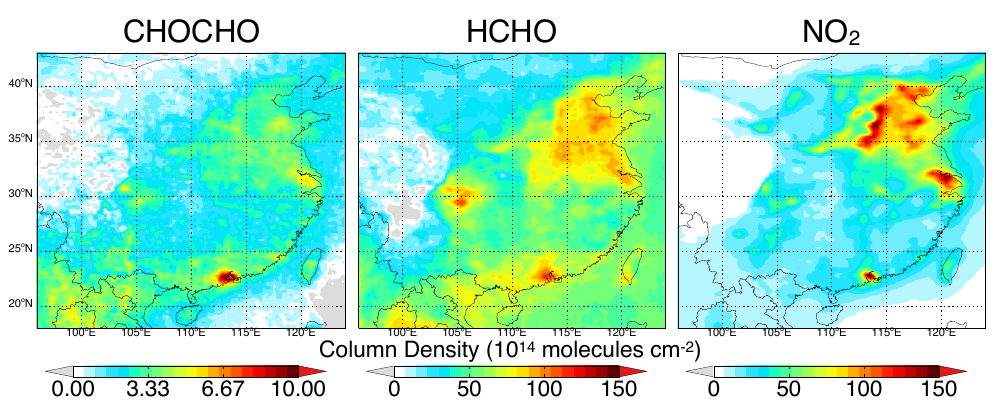
Figure 1. Annual mean vertical column densities of NO 2 , HCHO, and CHOCHO for 2006–2007. Values are OMI observations from Chan Miller et al. (2014) for CHOCHO, González Abad et al. (2015) for HCHO, and Bucsela et al. (2013) for NO 2 .